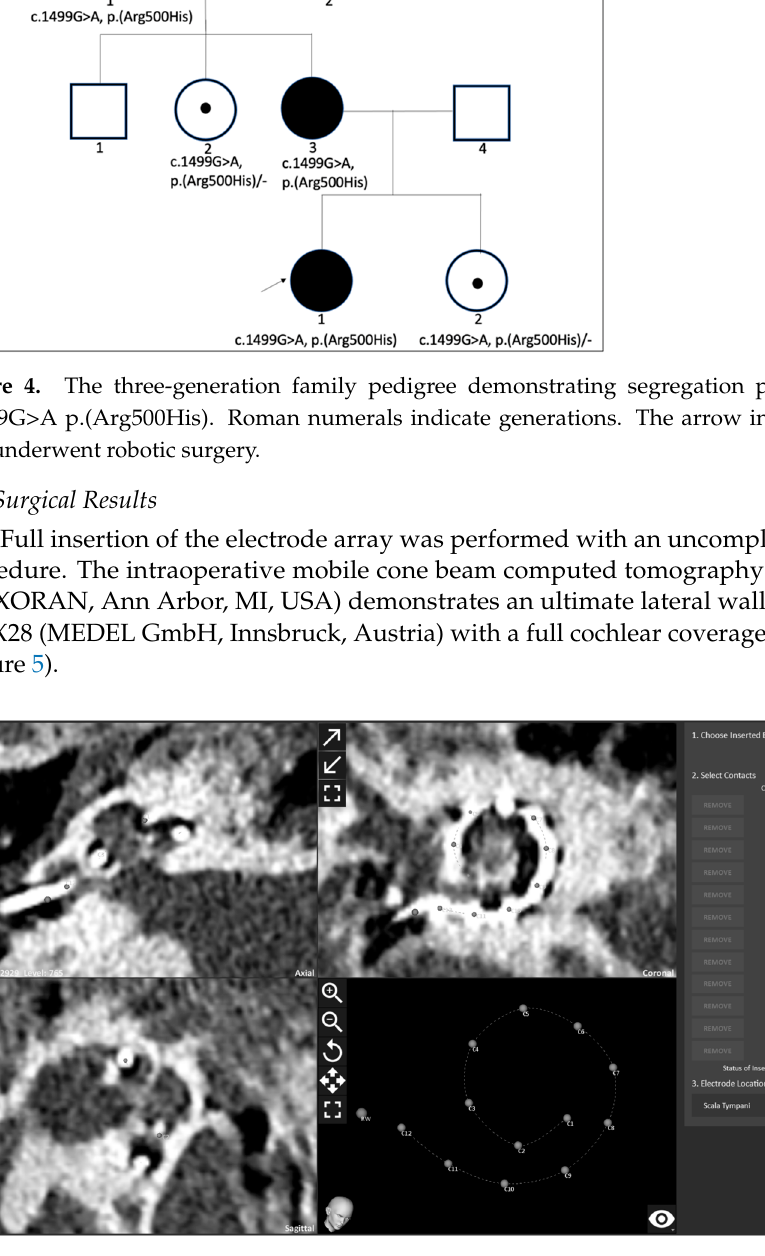
Figure 5. Post-op CBCT showing all fully inserted 12 electrodes in the cochlea. In the control computed tomography images taken after the surgery, the conven- tional cochlear implant on the left side and the RACIS on the right side are seen in the coronal and axial sections (Figure 6). The conventional placement of the CI on the left side was combined with the obliteration of the mastoidectomy with bony dust. A clear altera- tion in the bony structures and disrupted mastoid air cells can be seen compared to the minimally invasively operated right side.